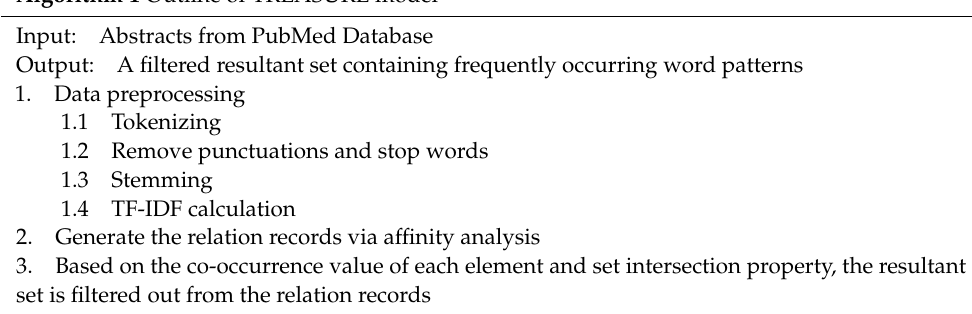
Algorithm 1 Outline of TREASURE